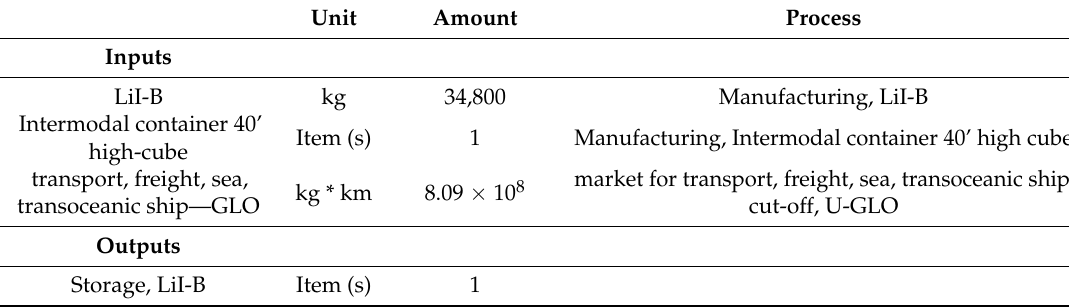
Table A25. Manufacturing Storage,